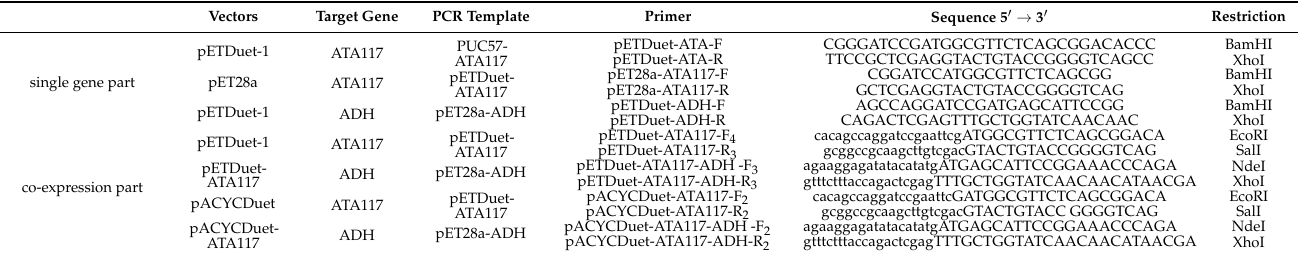
Table 1. PCR process for the construction of recombinant plasmids.